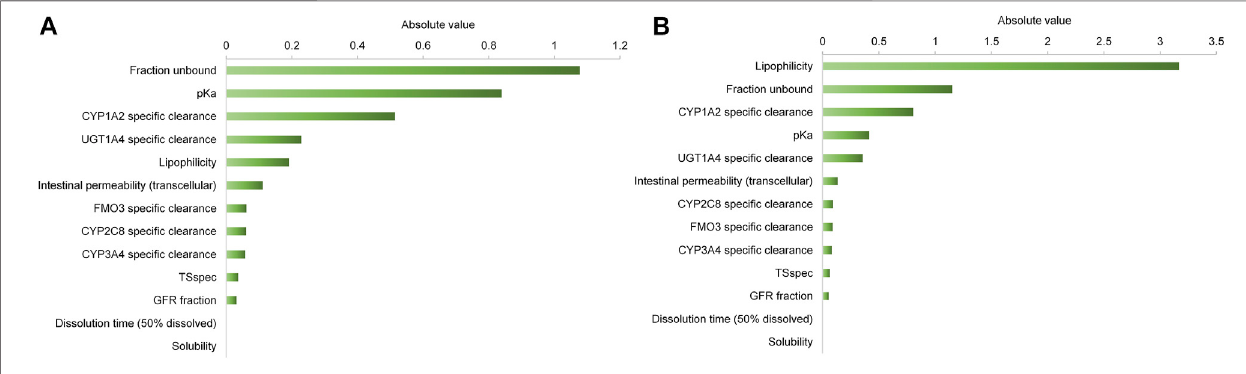
FIGURE4| Sensitivityanalysisoftheolanzapinemodel.Sensitivityofthe fi nalmodeltosingleparameterswasmeasured asrelativechangeofAUC 0 (cid:12) ∞ afterasingle oral dose (A) or AUC from time of the last dose to in fi nity after multiple administrations (B) . A sensitivity value of +1.0 denotes that a 10% increase of the examined parameter causes a 10% increase of the simulated